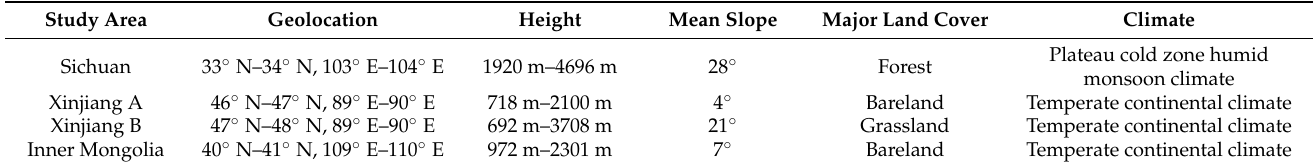
Table 1. Study area information.